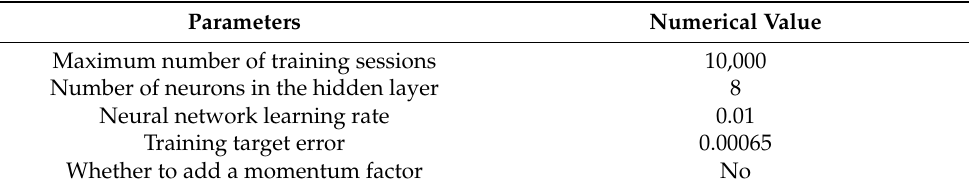
Table 3. Specific parameters of network